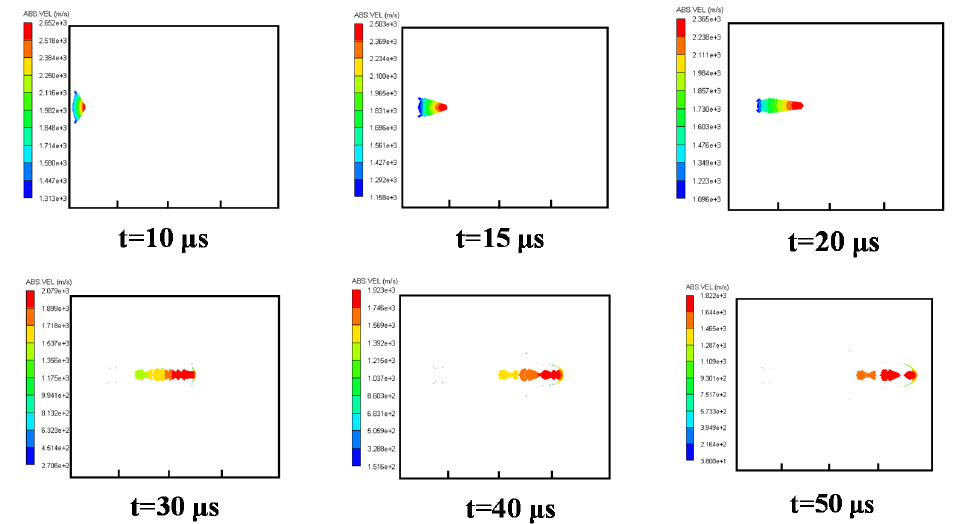
Figure 11. Velocity distribution of the EFP for Case